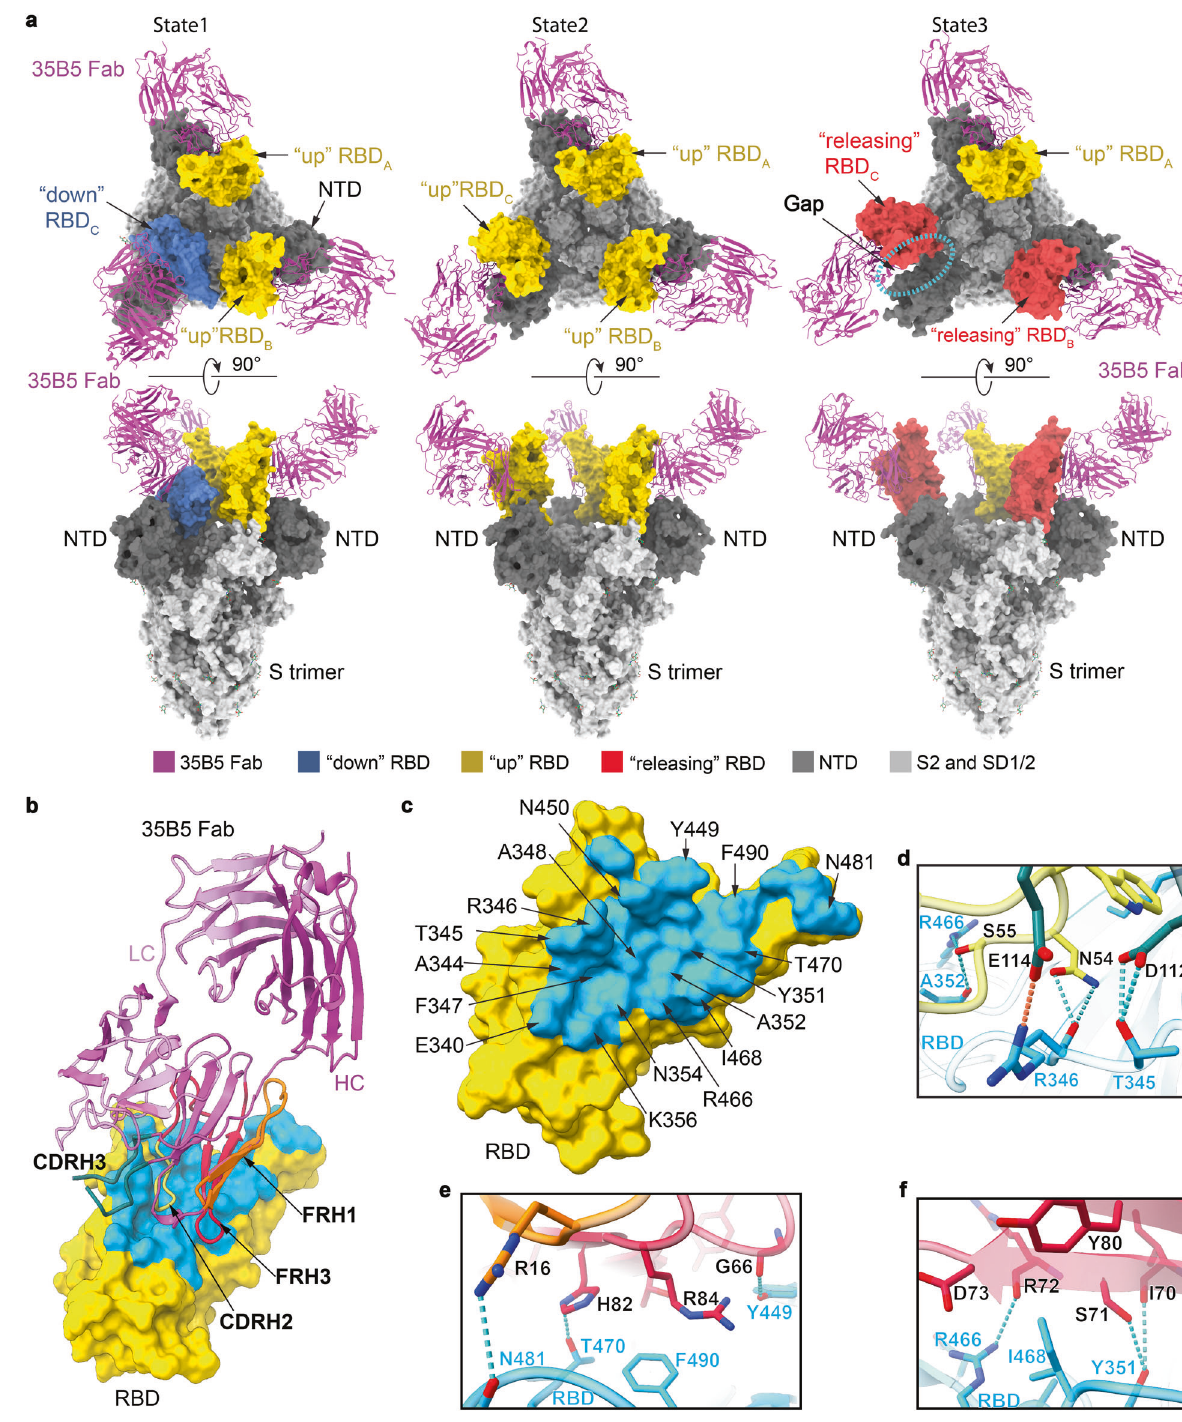
Fig. 3 Cryo-EM structures of the spike protein S-6P complexed with 35B5 Fab. a The structures of the S-6P-35B5 Fab complex in three states. The S trimer is represented as surface. 35B5 Fab is shown in cartoon and colored in purple. The “ down ” , “ up ” , and “ releasing ” RBD domains are colored in blue, yellow, and red, respectively. The NTD domain of the S trimer is colored in deep gray. The SD1, SD2, and S2 domains are colored in light gray. The gap caused by 35B5 Fab between the “ releasing ” RBD and NTD domains is highlighted with dashed lines. b Interactions of 35B5 Fab with “ up ” RBD. The interacting residues within 4 Å in RBD are colored in cyan. The RBD-interacting regions CDRH2, CDRH3, FRH1 and FRH3 of 35B5 Fab are colored in yellow, blue, orange, and red, respectively. c The 35B5 epitope on RBD. The epitope residues are labeled as indicated. d – f Detailed interactions of the CDR ( d ) and FR regions ( e , f ) of 35B5 Fab with RBD. Hydrogen-bond and salt- bridge interactions are shown as blue and orange dashed lines, respectively